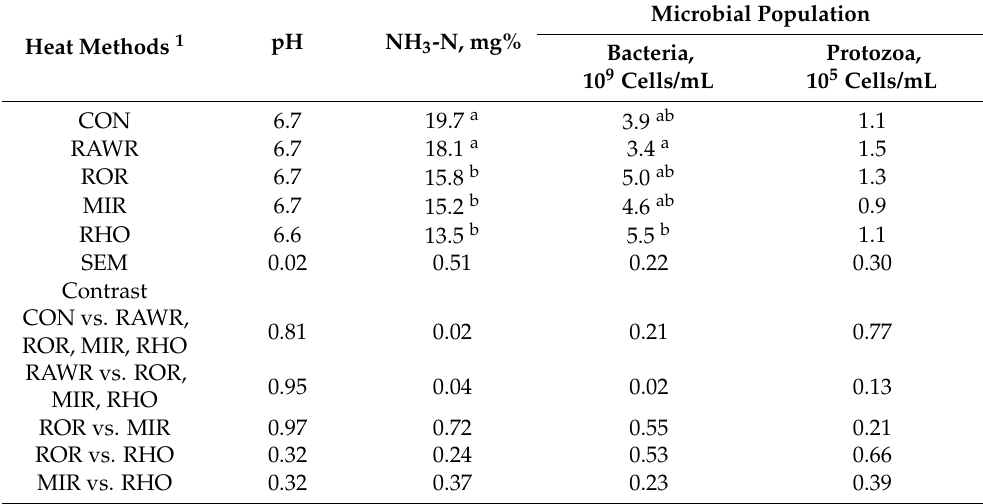
Table 4. Effect of different heated rubber seed kernel on pH, NH 3 -N, and microbial